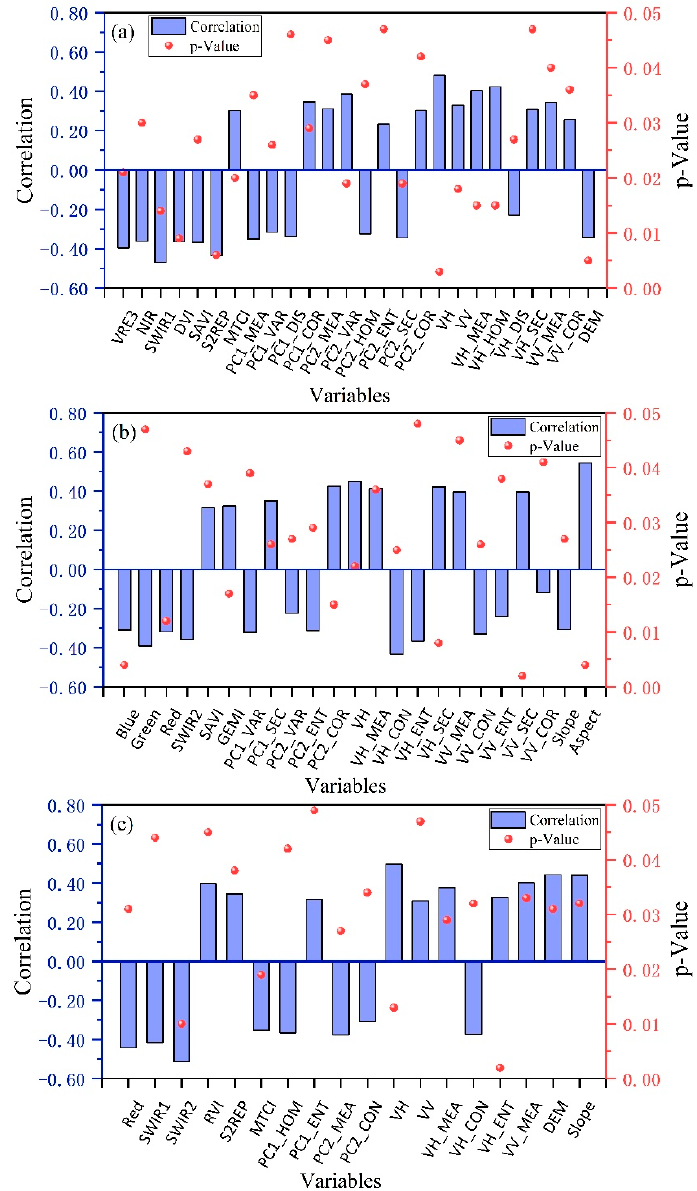
Figure 6. Variables significantly associated with AGB for each UGS type: ( a ) broadleaf forest; ( b ) coniferous forest; ( c ) shrub-grass vegetation.